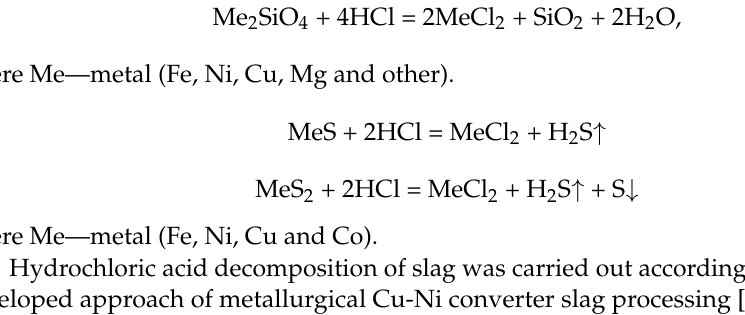
Figure 4. SEM micrograph of slag showing components of the slag: ( a )—sample 807, ( b )—sample 809.